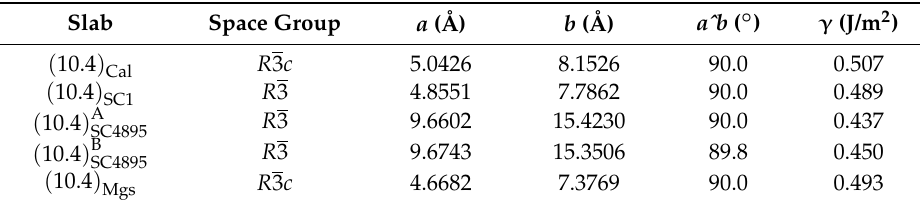
Table 2. Optimized 2D cell parameters ( a , b , a ˆ b ) and surface energies ( γ ) of the (10.4) slabs of calcite, magnesite and